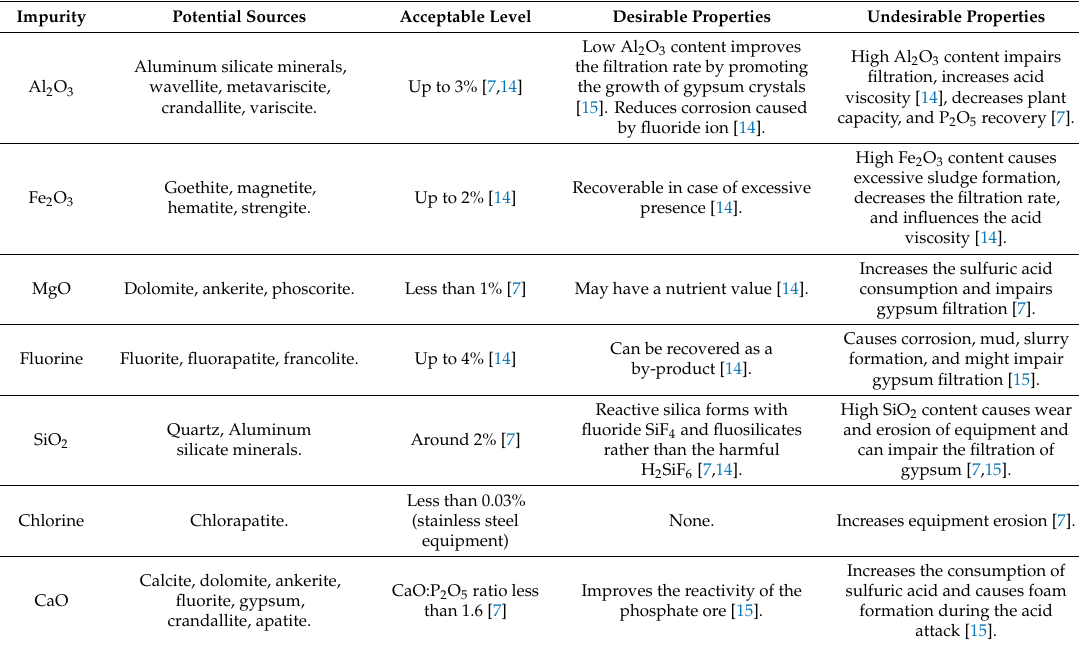
Table 3. Potential e ff ects of phosphate impurities and their acceptable